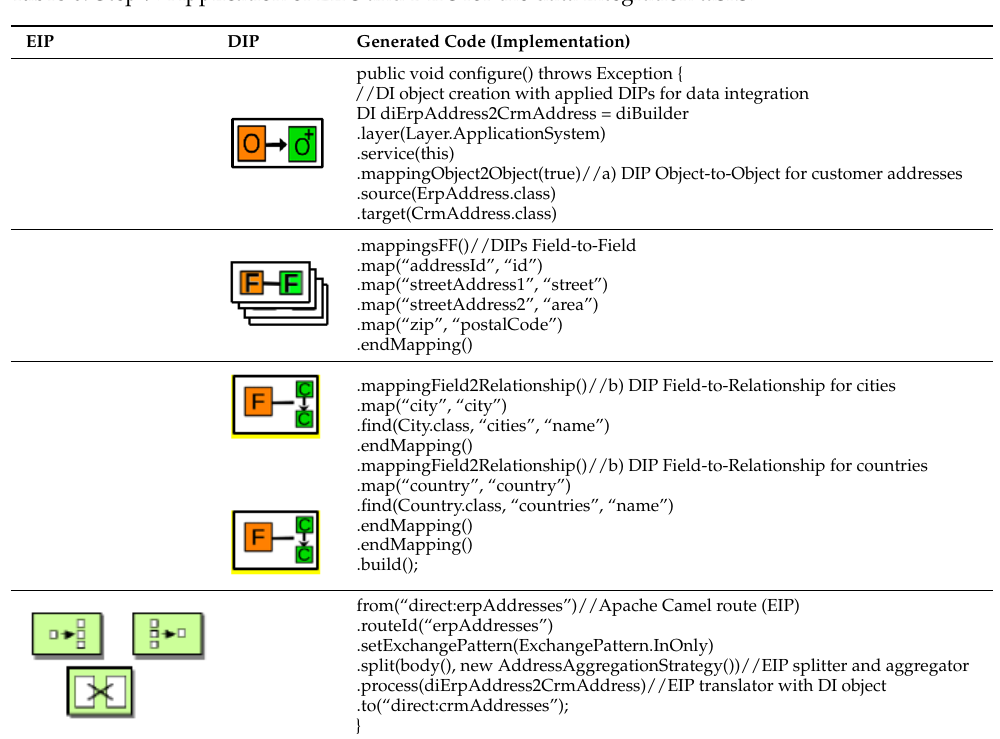
Figure 10. Visual model-based specification of the data integration example for customer addresses.